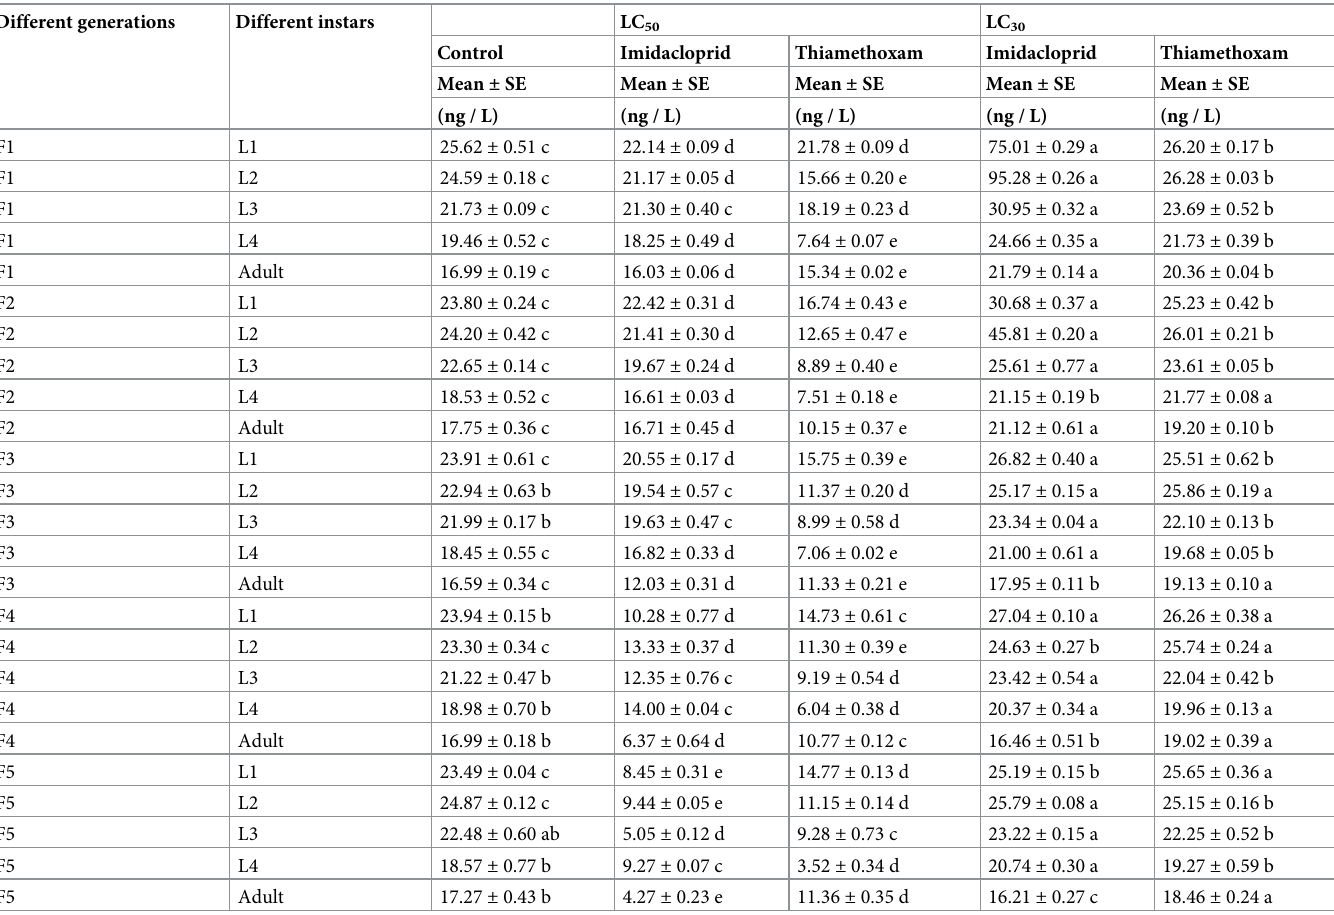
Different lowercase letters of the same row in the table indicate significant differences on molting hormone titer, and the significance level is 0.05. F1, F2, F3, F4, F5 = The first, second, third, fourth, and fifth generation. L1, L2, L3, L4, L5 = The first, second, third, fourth, and fifth instar nymphs. The titer unit of molting hormone is “ng /